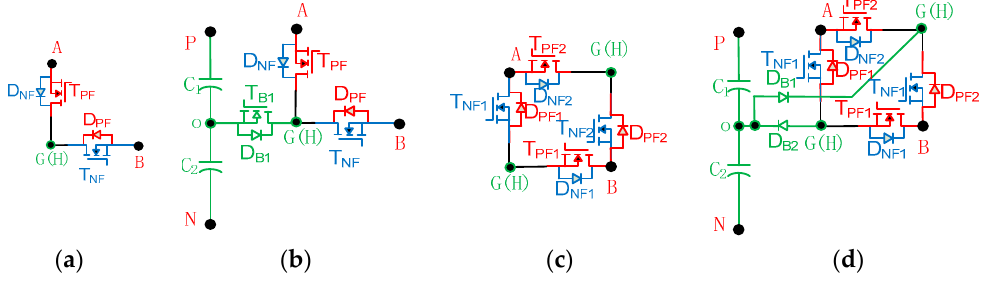
Figure 6. Indirect Connection of NPC cell circuits based on topology family without an extra diode. ( a ) case #1; ( b ) NPC cell #1 under case #1; ( c ) case #2; ( d ) NPC cell under case #2.